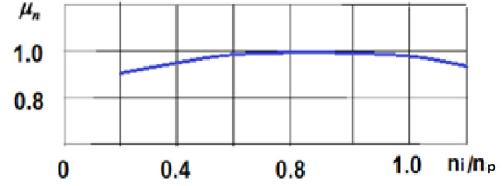
Figure 5. Coefficient of the power